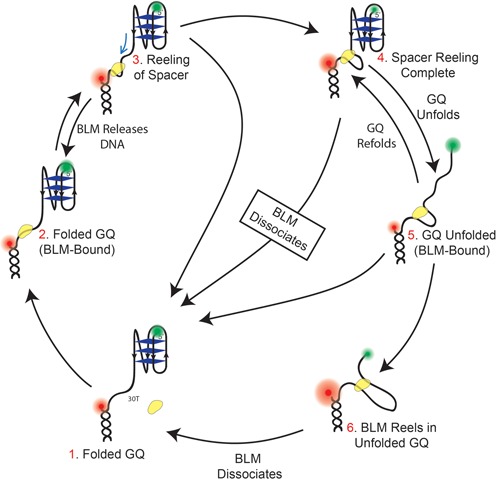
A model describing different phases of BLM-GQ interactions and the underlying dynamics for a substrate with a long DNA spacer (e.g. 30T spacer in pd-30ThGQ) in the presence of ATP. Step 1: The GQ is folded and BLM is not bound to the 30T spacer. Step 2: BLM binds to the spacer while GQ is still folded. Step 3: BLM reels in the spacer which results in an FRET increase. Step 4: Reeling of the spacer is complete and BLM interacts with GQ. At this point several pathways could be followed. BLM could dissociate from DNA without unfolding the GQ or it could release the reeled-in spacer without dissociating from DNA. Both of these would result in a large FRET decrease. Alternatively, BLM could unfold the GQ which would lead to Step 5. Similarly, GQ unfolding should result in a FRET decrease although significantly smaller than what would be observed in the other two alternatives. Step 6: BLM reels in the ssDNA that becomes available after the GQ is unfolded. The evidence for this step is the very high EFRET levels (EFRET > 0.80), we observe in the smFRET traces. Such high EFRET would not be observed if the 23 nt of ssDNA that becomes available after GQ is unfolded is at least partially reeled in.